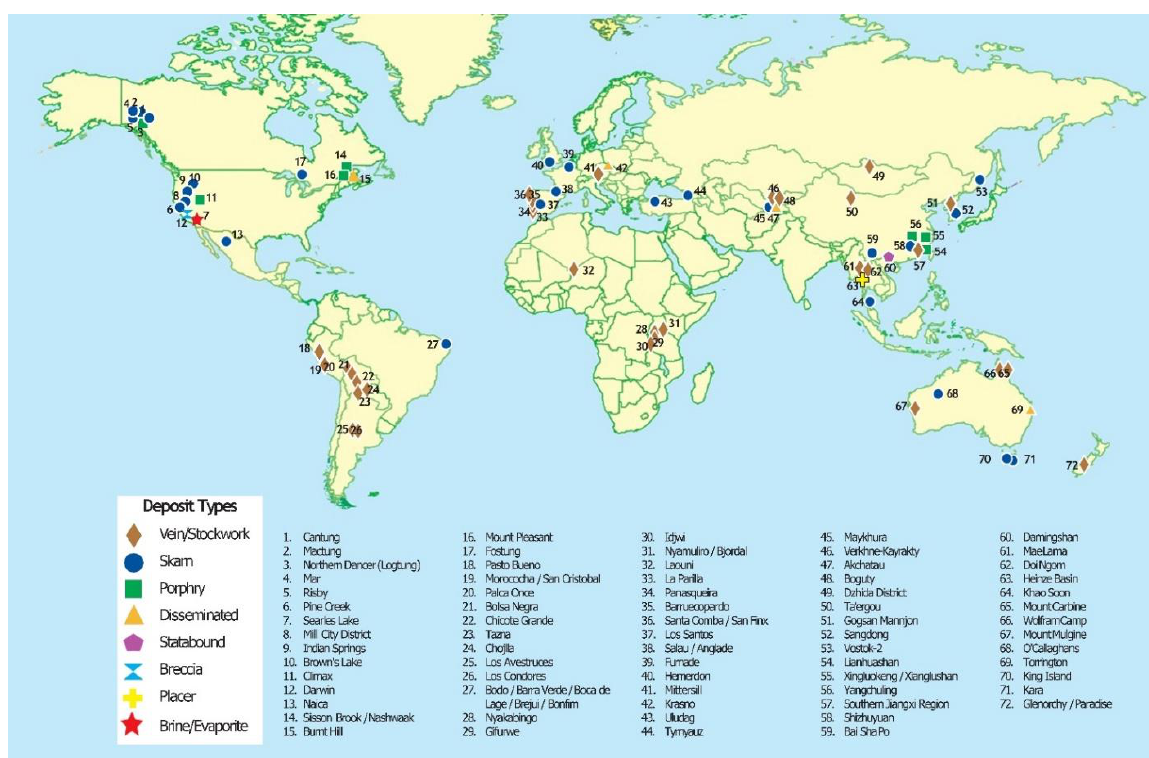
Figure 3. Location and type of major tungsten deposits and districts [22].